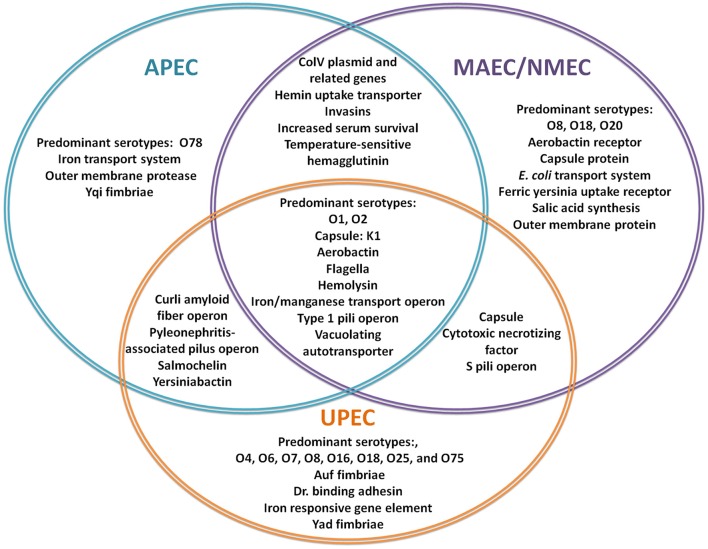
Virulence factors involved in ExPEC infections. The Venn Diagram represents the most commonly reported, shared and individual, virulence factors for APEC (blue), MAEC/NMEC (purple), and UPEC (orange). (Knöbl et al., 2001; Johnson et al., 2006; Lloyd et al., 2007; Wiles et al., 2008; Zhu et al., 2010; Nazemi et al., 2011; Spurbeck et al., 2011; Logue et al., 2012; Zhu Ge et al., 2014; Huja et al., 2015; Wang et al., 2015; Wijetunge et al., 2015).